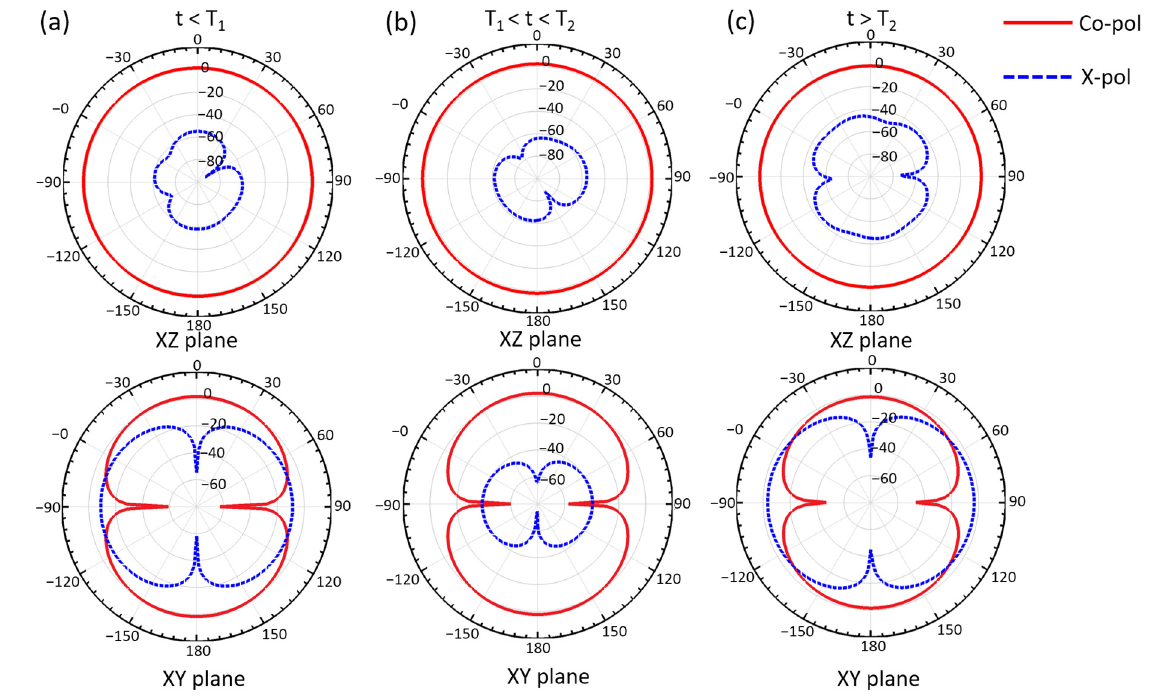
Figure 5. Simulated radiation pattern of the XY plane and XZ plane of the ShMoA at ( a ) t < T 1 , ( b ) T 1 < t < T 2 , and ( c ) t > T 2 .